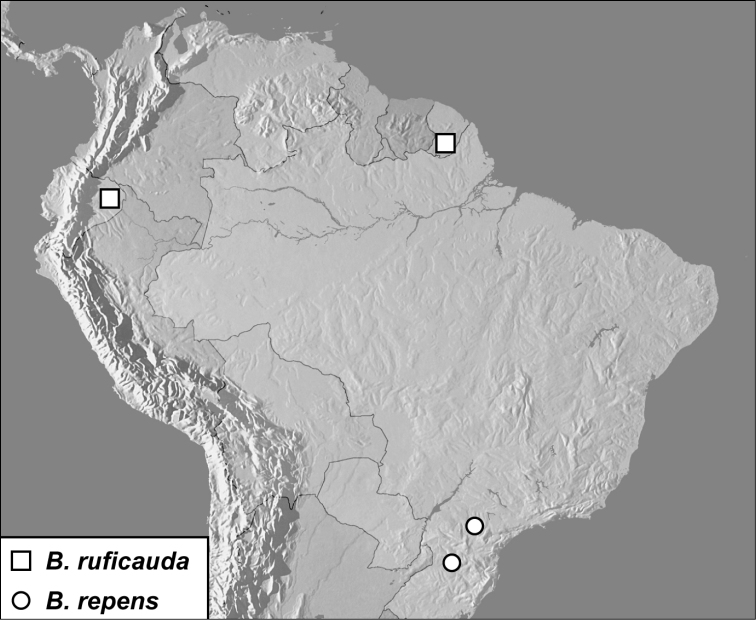
Baconia ruficauda group records.